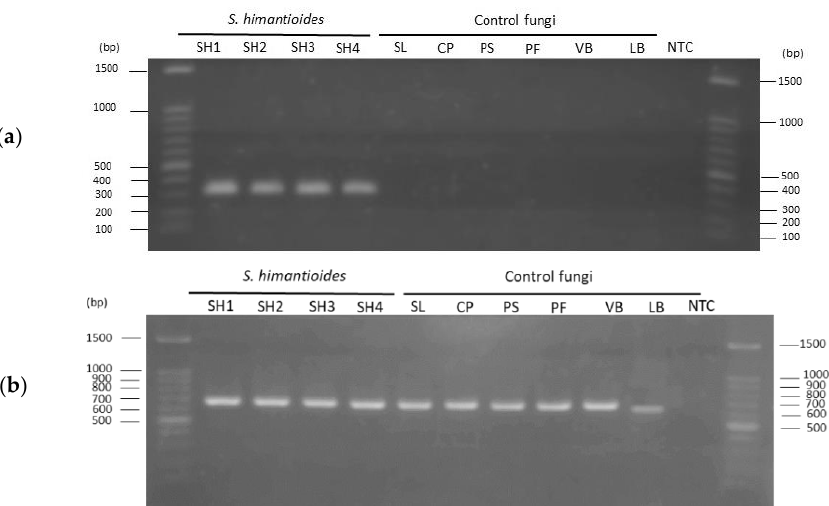
Figure 2. Comparison of end-point PCR results between species-specific and universal primer sets by agarose gel electrophoresis. Lanes are designated with abbreviations for the species listed in Table S3. Size markers are in the first and last lanes: ( a ) Species-specific primer set SHF/SHR detected Serpula himantioides (SH1, SH2, SH3, and SH4), and there was no reaction with the control fungi. ( b ) Universal primer set ITS5/ITS4 detected all fungi. All primer sets yielded negative results for negative control